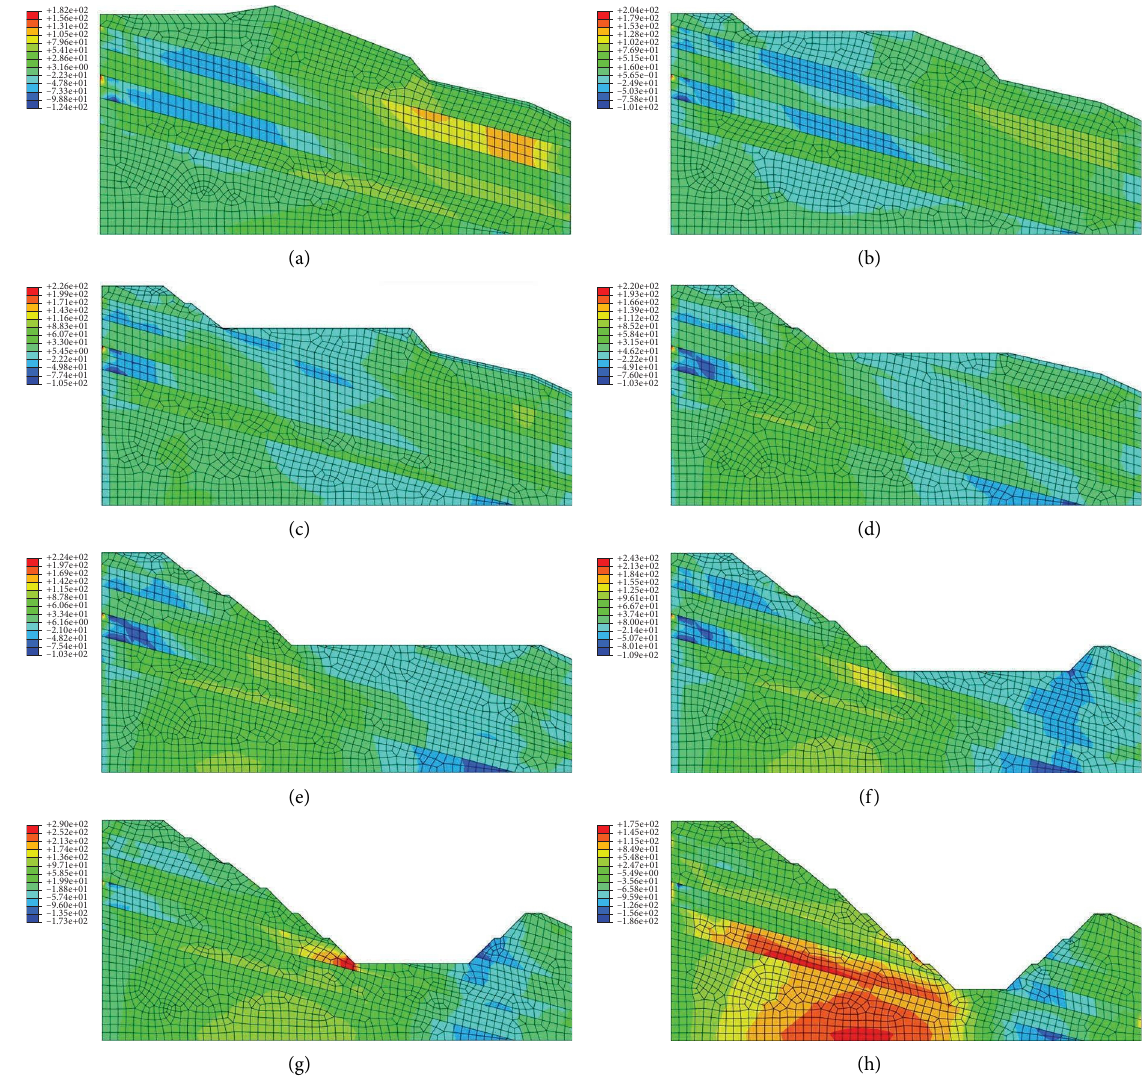
Figure 2: Nephogram of shear stress distribution: (a) before excavation, (b) seventh stage excavation, (c) sixth stage excavation (d) ffth stage excavation, (e) fourth stage excavation, (f) third stage excavation, (g) second stage excavation, and (h) frst stage